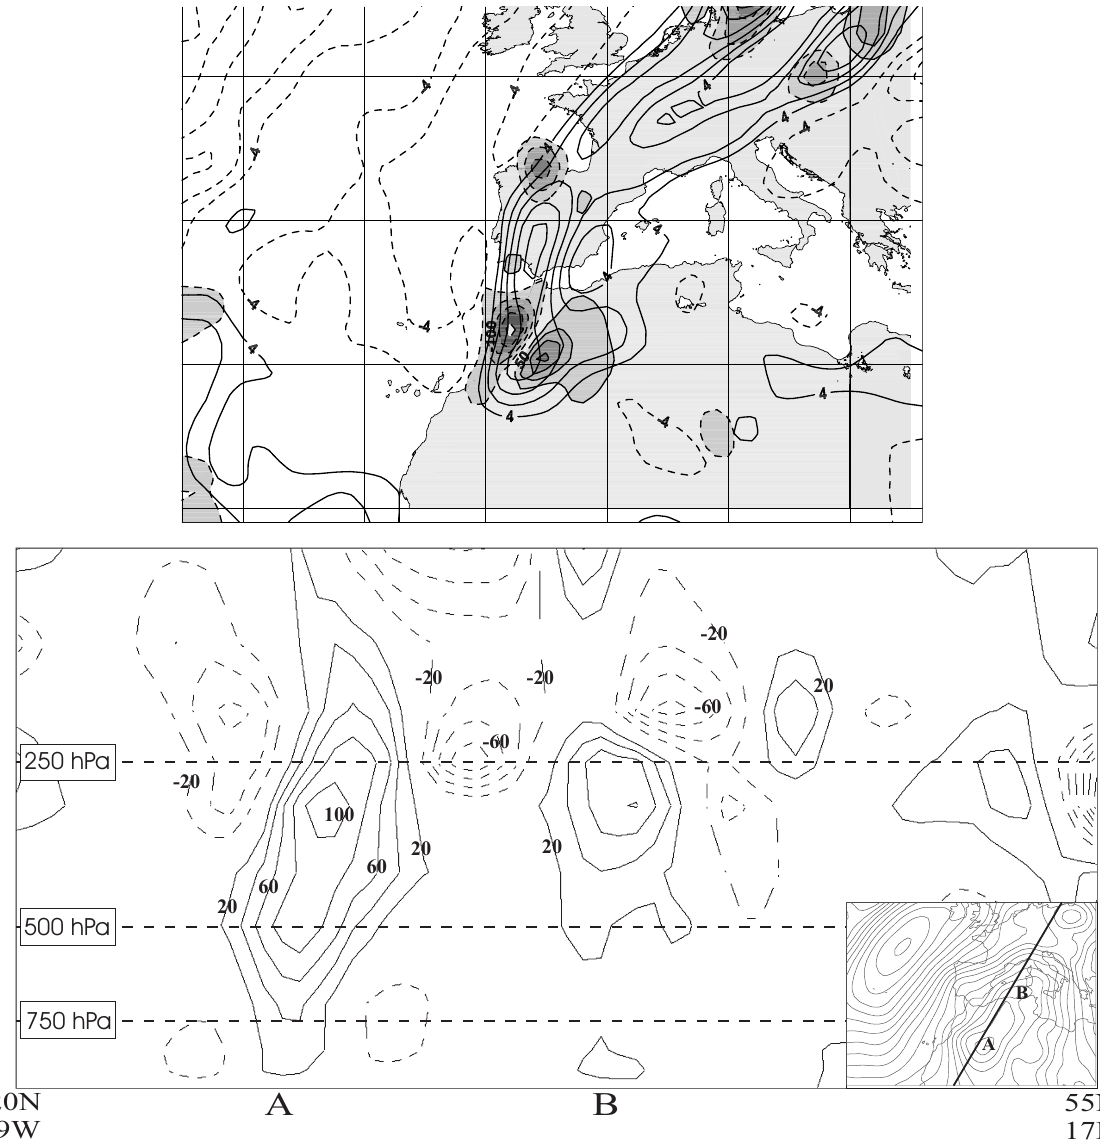
Fig. 5. (a) Relative vorticity (10 − 5 s − 1 , non-shaded contours) and Q -vector forcing, − 2 ∇ p · Q , of the quasi-geostrophic omega equation (10 − 18 mkg − 1 s − 1 , shaded contours) at 400hPa; and (b) Vertical cross section along the line depicted in the right bottom map, showing the Q -vector forcing of the quasi-geostrophic omega equation (10 − 18 mkg − 1 s − 1 ). A and B locations are indicated in the map for reference. These fields are diagnosed from ECMWF reanalysis at 18:00UTC, 20December1979. Dashed lines indicate negative values in both